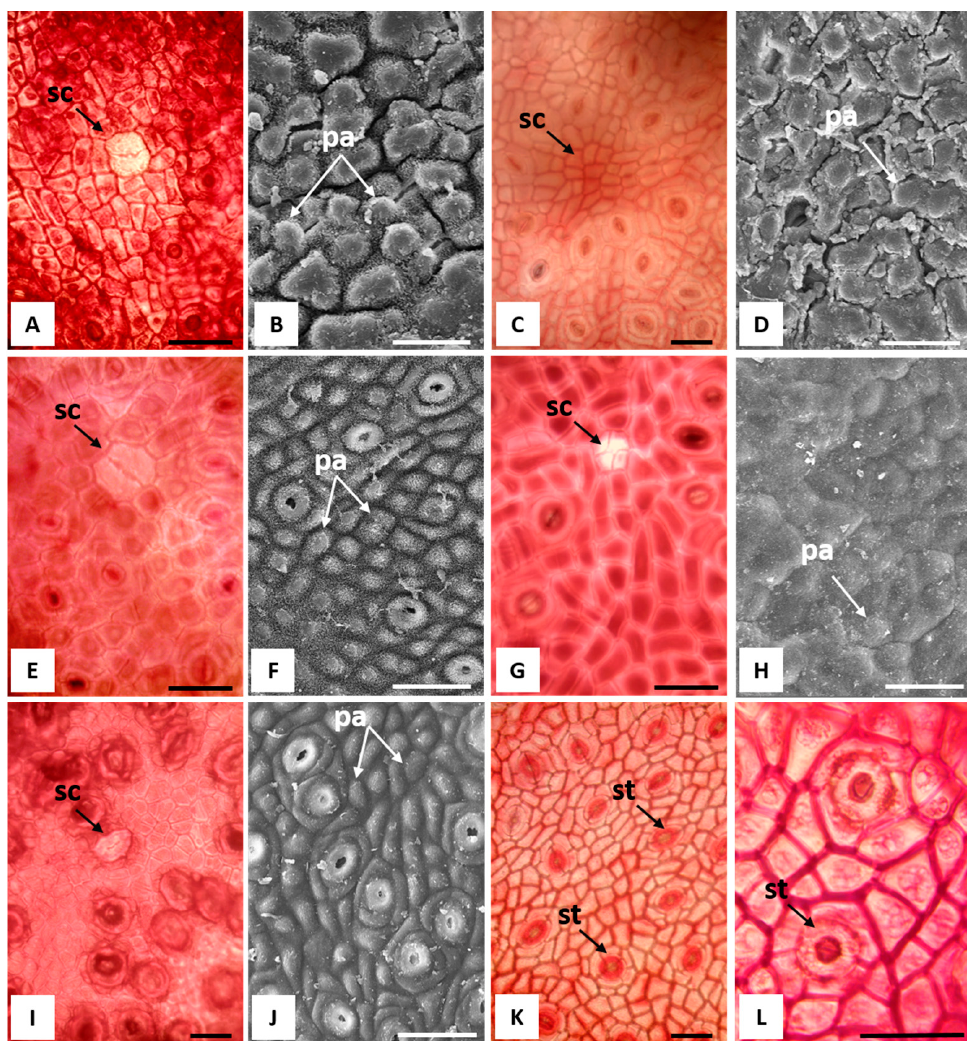
Figure 4. LM and SEM images: E. alba ( A , B ), E. eugenioides ( C , D , K ), E. fasciculosa ( E , F ), E. robusta ( G , H , L ), and E. stoatei ( I , J ). LM: ( A , C , E , G , I )—leaf epidermis stained with safranin and showing overlying cells covering the secretory cavities. SEM: ( B , D , F , H , J )—leaf surface with more ( B , F , J ) or less ( D , H ) evident papillae. LM: ( K , L )—two types of stomata, actinocytic and anomocytic, are shown; actinocytic stomata in the epidermis of E. eugenioides ( K , arrows), and anomocitic stomata in the epidermis of E. robusta ( L , arrow). Overlying cells (sc) in correspondence with the secretory cavities, papillae (pa), and stomata (st). 50 µ m